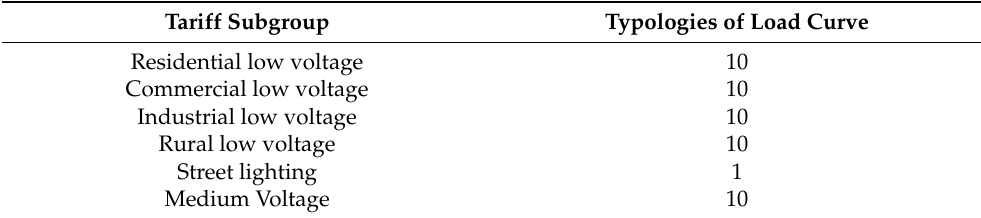
Table 2. Load curves typologies for load